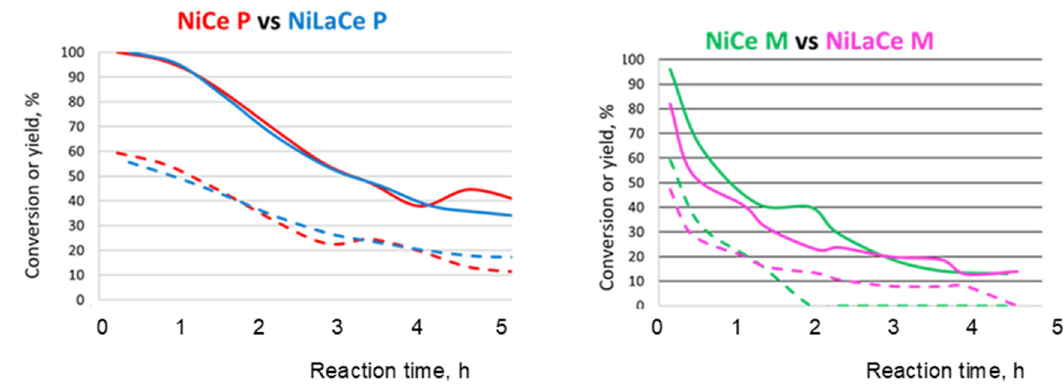
Figure 6. Catalytic activity in the ethanol steam reforming on NiLaCe P ( left ) and NiLaCe M ( right ) catalysts in comparison with the non-doped samples: ethanol conversion (full line) and hydrogen yield (dotted line).